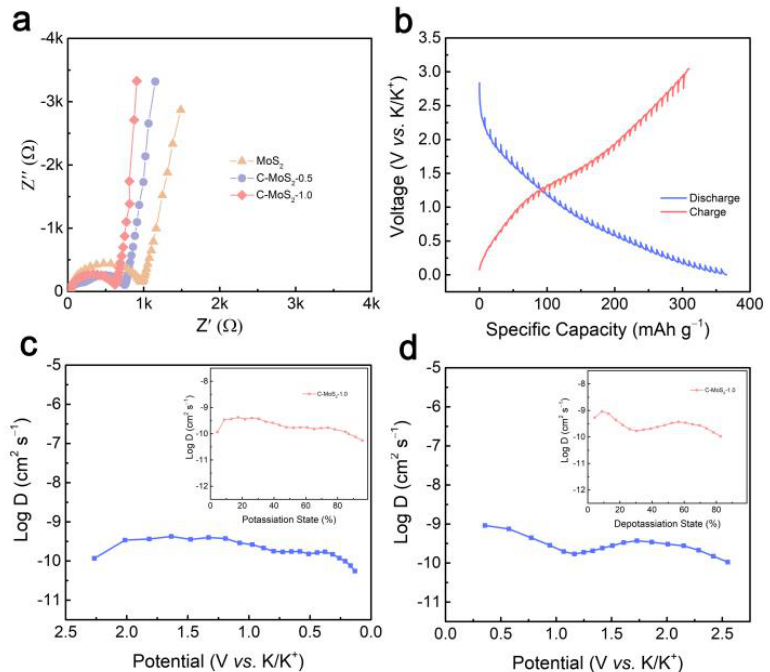
Figure 5. Reaction kinetics of samples. ( a ) Nyquist plots of the MoS 2 and C-MoS 2 electrodes. ( b ) GITT test of C-MoS 2 -1 electrode. ( c , d ) K + diffusion coefficients from GITT of C-MoS 2 -1 electrode under different voltage. Inset: Diffusion coefficient under different potassiation and depotassiation